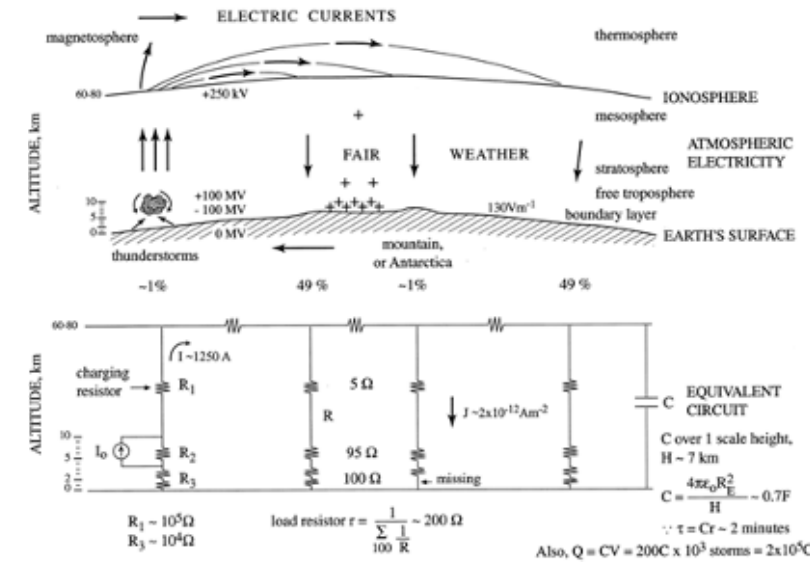
Figure 6. Global circuit concept diagram (from Rycroft et al., 2000).